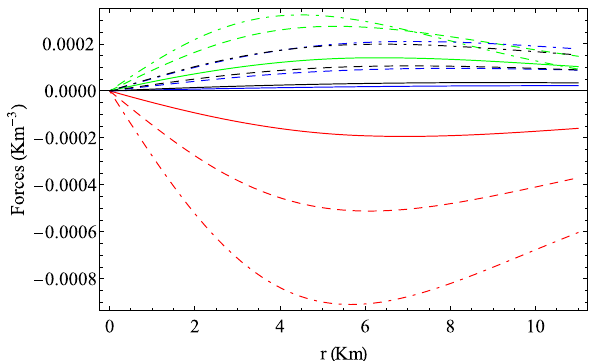
Fig. 29 Radial variation of different forces inside PSR J1614-2230. Here red, green, blue and black lines represent gravitational force ( F g ), hydrostatic force ( F h ), anisotropic force ( F a ) and electrostatic force ( F e ) respectively. Solid, dashed and dotdashed curves correspond to D = 4, D = 5 and D = 6 respectively